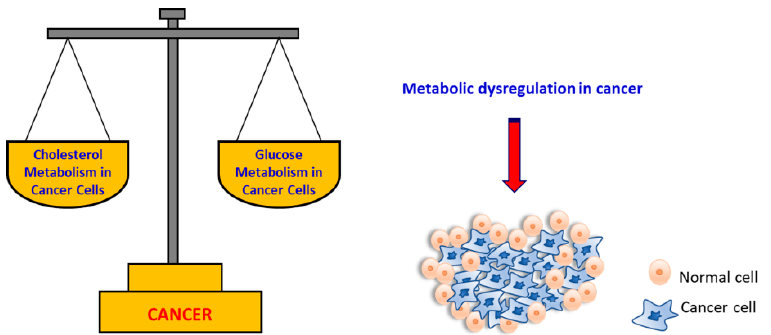
Figure 1. Metabolic reprogramming in cancer involves glucose and cholesterol metabolism altera- tions. The energy production from fats has the same weight as alterations in glucose metabolism in supporting the viability of cancer cells.